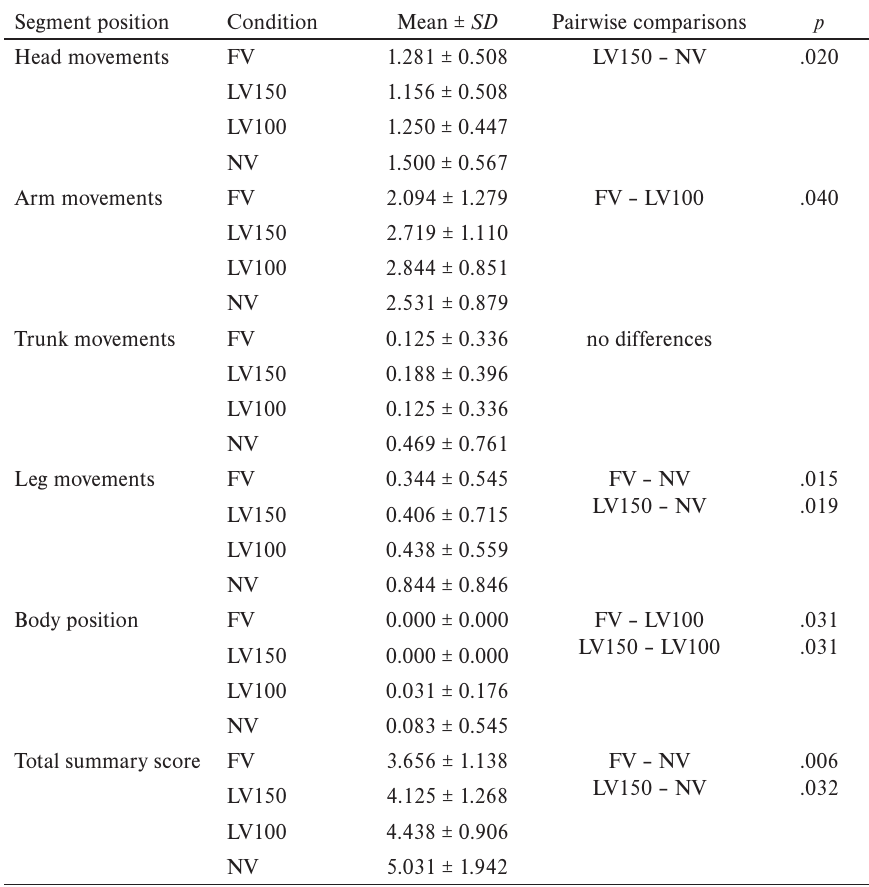
Means of errors, standard deviations and post-hoc analyses of observed body segments in different visual conditions